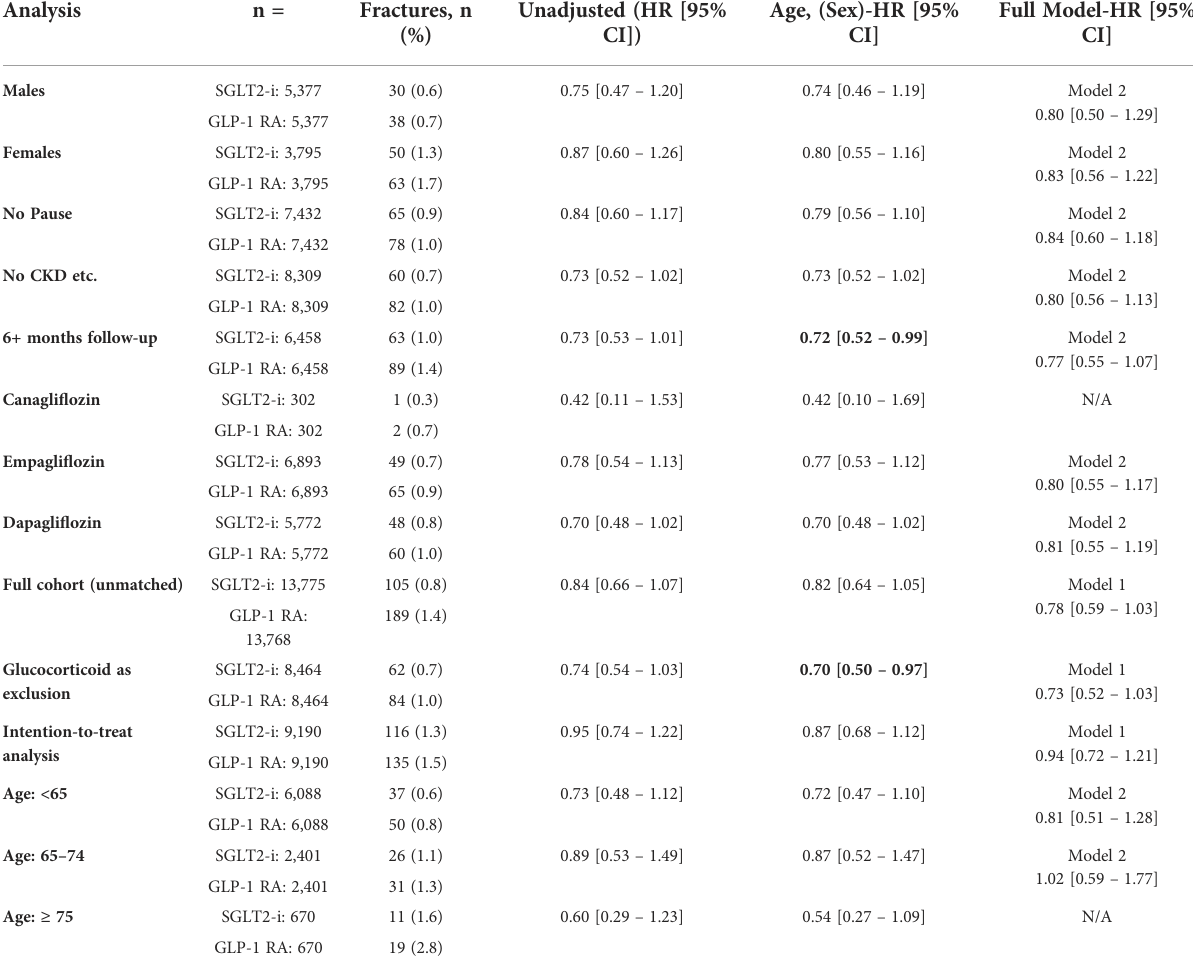
TABLE 3 Hazard Ratios for MOF in subgroup and sensitivity